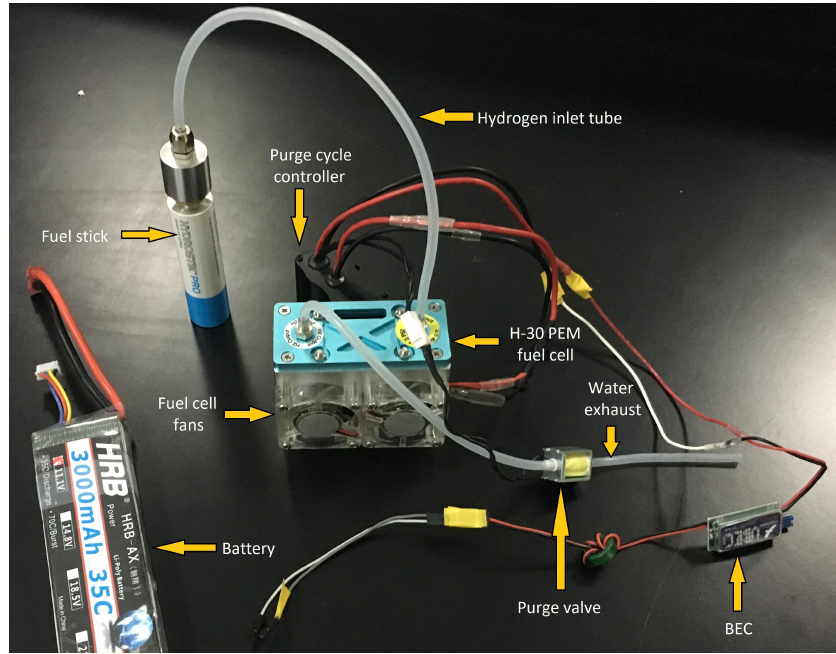
Figure 6. Components of the drone power supply and battery cooling